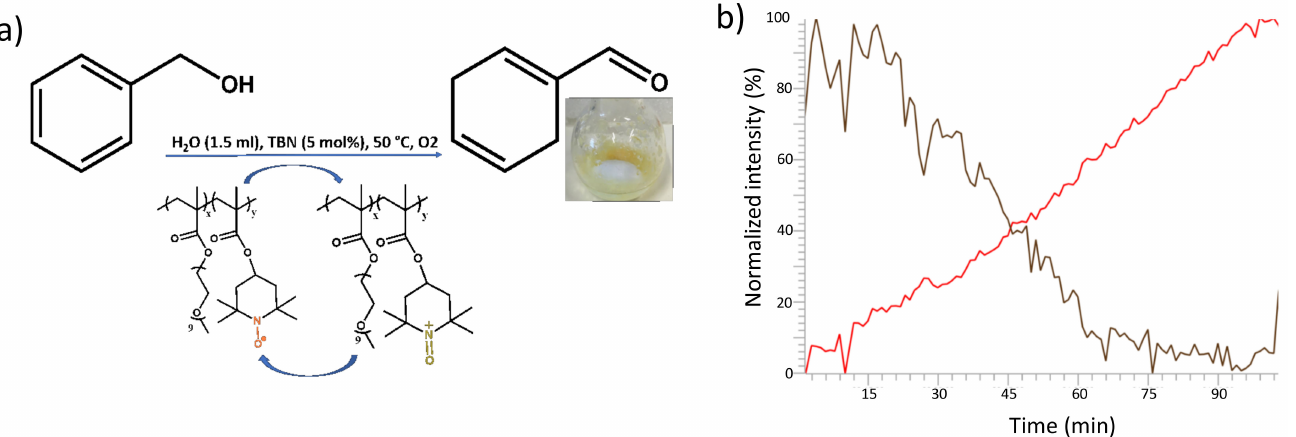
Figure 4. ( a ) Reaction conditions for benzyl alcohol oxidation. ( b ) Evolution of the normalized integration of the infrared spectra of benzylic alcohol and benzaldehyde during the oxidation reaction of benzyl alcohol (black curve) into benzaldehyde (red curve) over